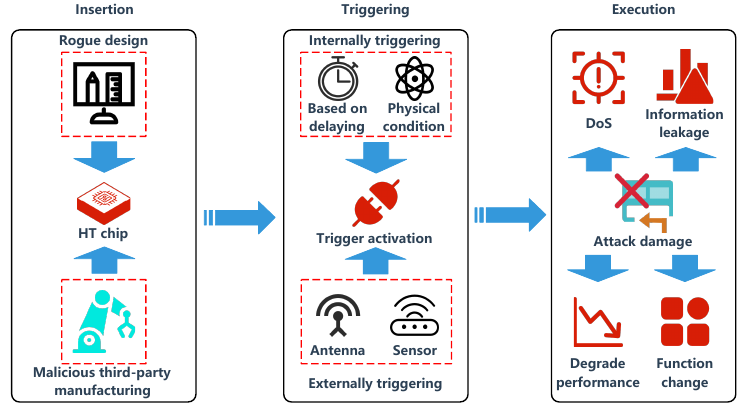
Figure 7. Insertion, triggering, and execution for HTs.